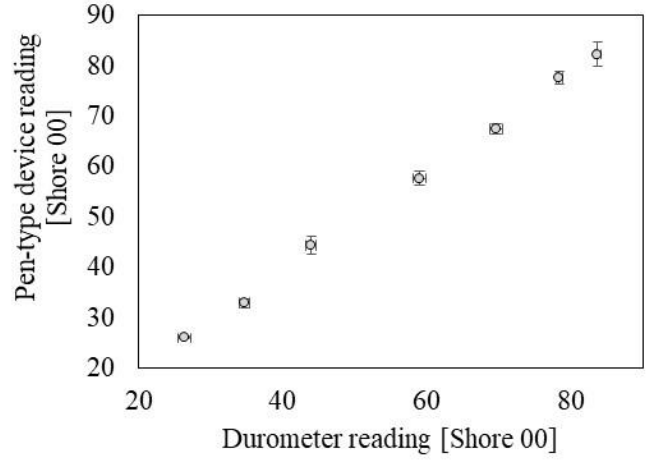
Figure 5. Hardness measurement performance of the pen-type device compared with durometer readings for the reference silicone rubber blocks.